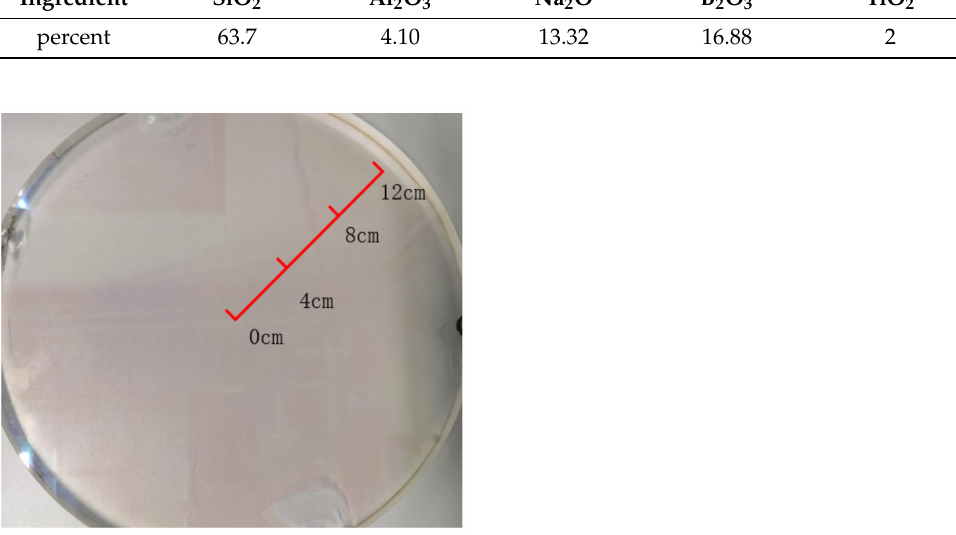
Figure 2. Window glass under Thomson scattering diagnosis, 28 cm in diameter and 2 cm in